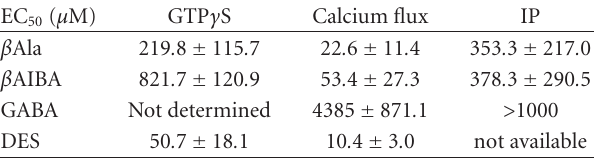
Table 1: Agonistic potency of physiologically active substances to induce signals of